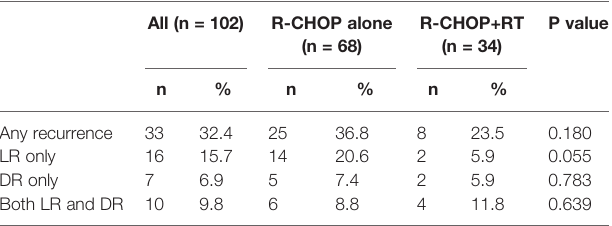
TABLE 3 | Patterns of